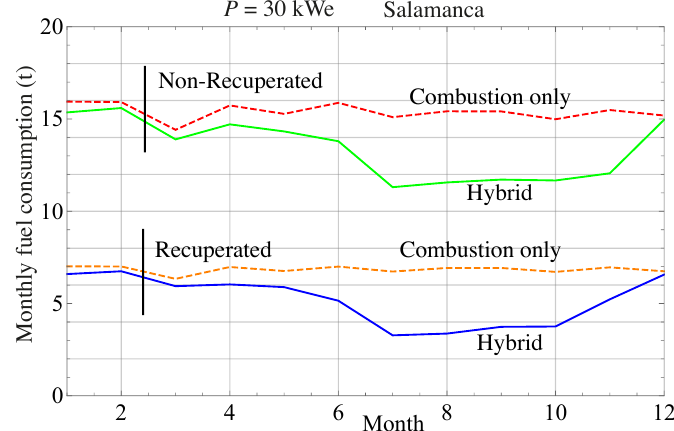
Figure 13. Fuel consumption per month in Salamanca, P = 30 kWe, in recuperative (bottom lines) and non-recuperative (top lines) cases. Plant operation in a pure combustion mode is shown with dashed lines and in the hybrid solar mode with solid